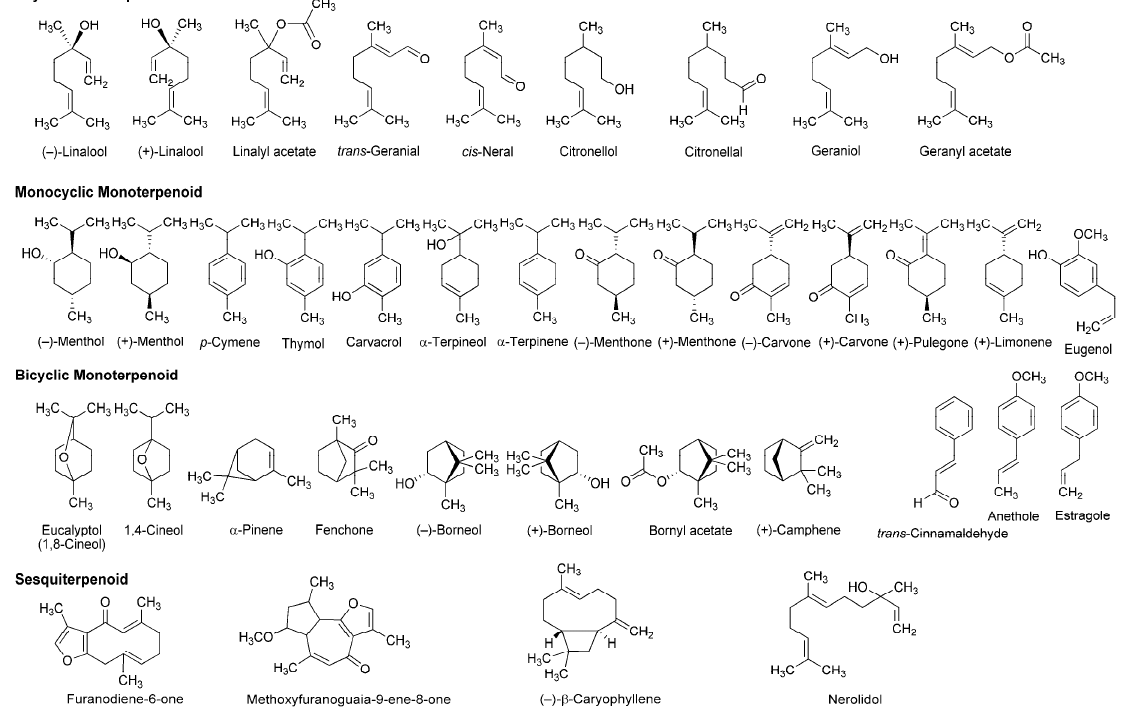
Figure 3. Terpenoids with the local anesthetic activity.